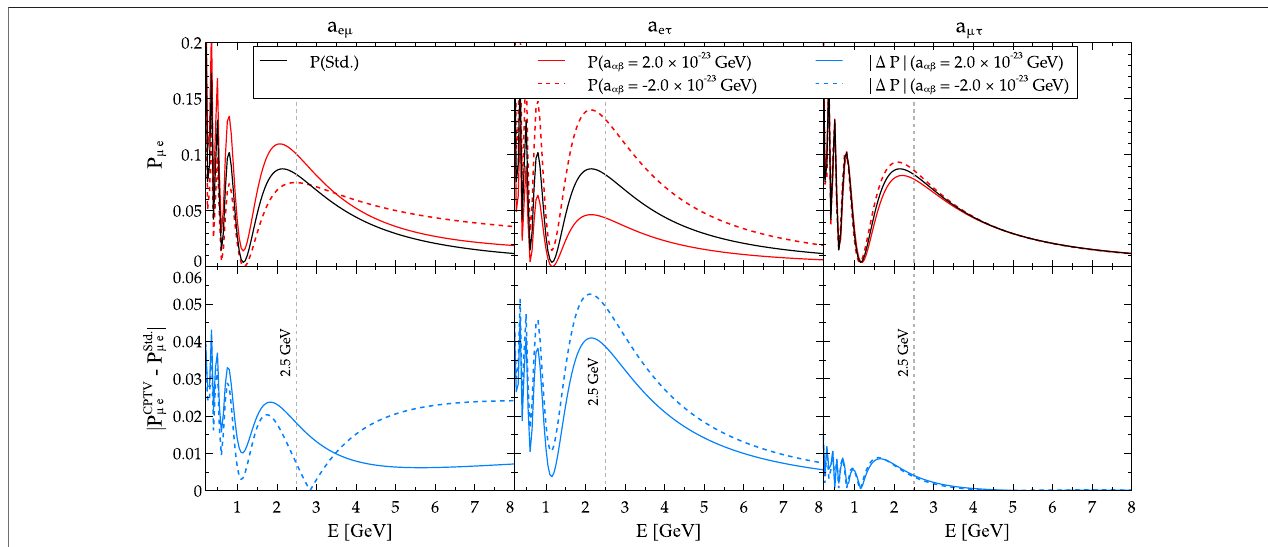
FIGURE3| Upper-panel:oscillationprobabilityasafunctionofenergyforthe ] μ → ] e channelwithstandardmattereffects(black)andanon-diagonalCPT-violating parameter (red). Lower-panel: the absolute difference between the above-mentioned standard oscillation and the CPT-violating oscillation probability. Each column represents a separate (unique) non-diagonal CPT-violating parameter that is set to ±2.0, ×, 10 – 23 GeV and is different from zero. The smallness of the parameters is just anotherproofoftheexquisitesensitivityofneutrinooscillationexperimentstotinyviolationsofCPTandLorentzinvariance.TheDUNEbaseline(1,300 km)hasbeen assumed, with a vertical line indicating the peak energy of the neutrino beam in DUNE.